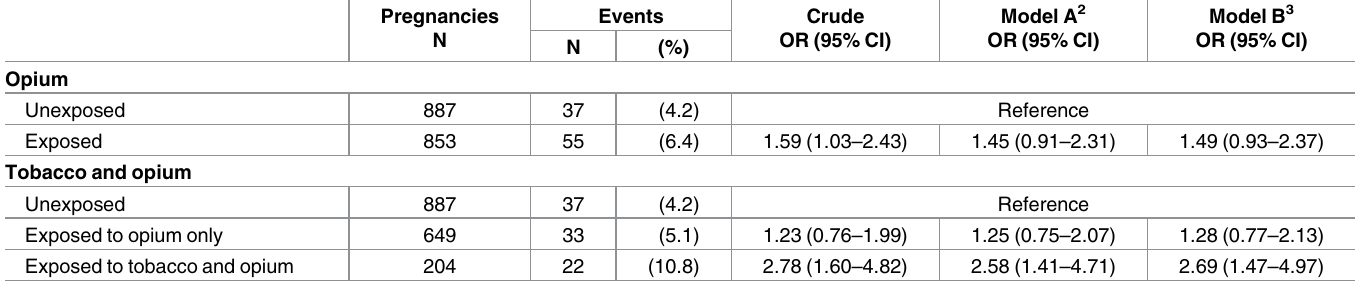
Table 3. Odds ratios (OR) and 95% confidence intervals (CI) for association between opium and tobacco use during pregnancy and risk of vaginal preterm delivery 1